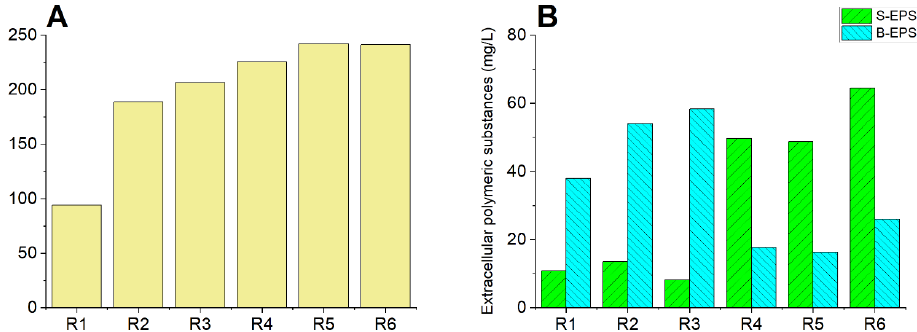
Figure 1. SCOD and extracellular polymeric substances content: ( A ) SCOD after 30 min of disinte- gration by various treatments. ( B ) Protein fraction of the S-EPS and B-EPS after 30 min of disintegration. R1: blank; R2: nZVI (0.2 g/L); R3: PDS (8.4 mM); R4: PDS (8.4 mM) + nZVI (0.2 g/L); R5: PDS (8.4 mM) + nZVI/Ag (0.2 g/L); R6: PDS (8.4 mM) + nZVI/Cu (0.2 g/L).